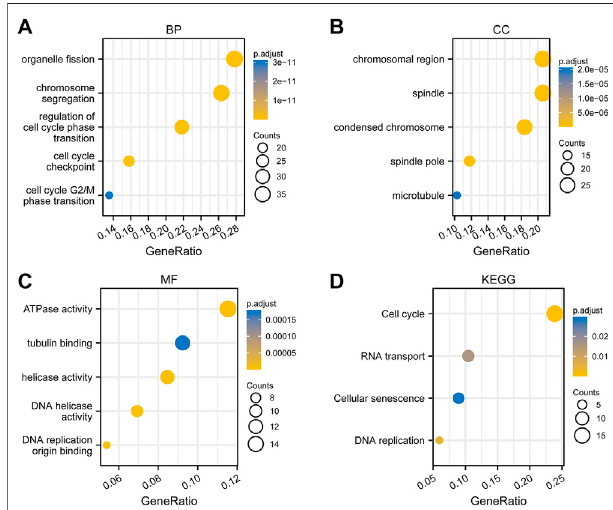
FIGURE 7 | Functional enrichment analysis of co-expressed genes of PSMD2 . (A) Biological progress of organelle fi ssion, chromosome segregation, and regulation of cell cycle phase transition. (B) Structural constituentsinthecondensedchromosome,spindle,andchromosomal region. (C) The molecular function of ATPase activity, tubulin binding, and DNA helicase activity. (D) KEGG pathway analysis indicated enrichment function in the cell cycle, RNA transport, and cellular